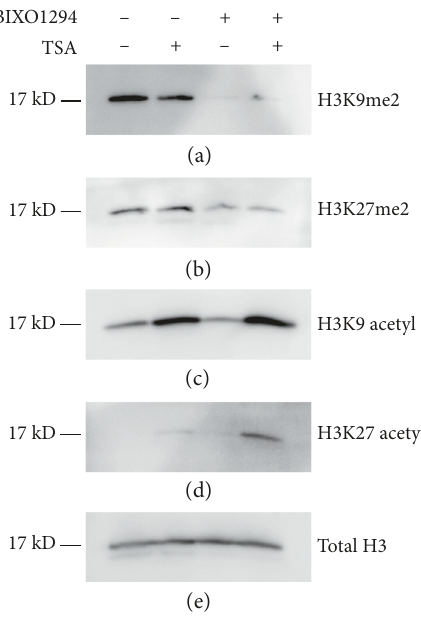
Figure 6: Modi fi cation of histone H3 by BIX01294 and TSA. Protein was isolated from bone marrow MSCs that were cultured in the absence or presence of BIX01294 and/or TSA. Following electrophoretic separation, the protein preparations were blotted with antibodies that recognized either total or speci fi cally modi fi ed histone H3. (a), (b) Immunoblots of total protein demonstrated that methylation of H3K9 and H3K27 was reduced by G9a HMTase inhibition by BIX01294. (c) Treatment with the HDAC inhibitor TSA led to increased acetylation at H3K9. (d) While culturing MSCs with TSA also enhanced H3K27 acetylation, this increase was slight. However, the coaddition of BIX01294 to TSA synergistically stimulated the acetylation of this lysine residue. (e) Blotting for total histone H3 as control veri fi ed that each cellular sample consisted of equal amounts of